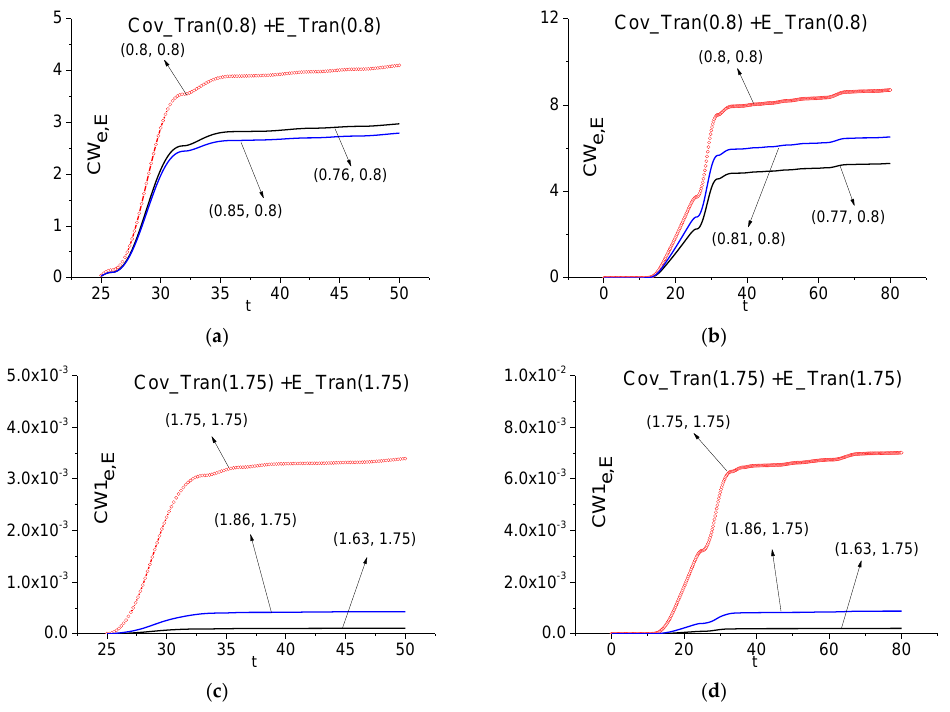
Figure 19. Time-dependent ICC CW e,E ( a ), ( b ), CW1 e,E ( c ), ( d ) calculated at the frequencies ν = 0.8 ( a ), ( b ), 1.75 ( c ), ( d ) in the time intervals t = [25, 50] ( a ), [0, 80] ( b ) for the signal transmitted through the medium with covering (Cov_Tran) and the standard signal transmitted through the non-covered medium (E_Tran).